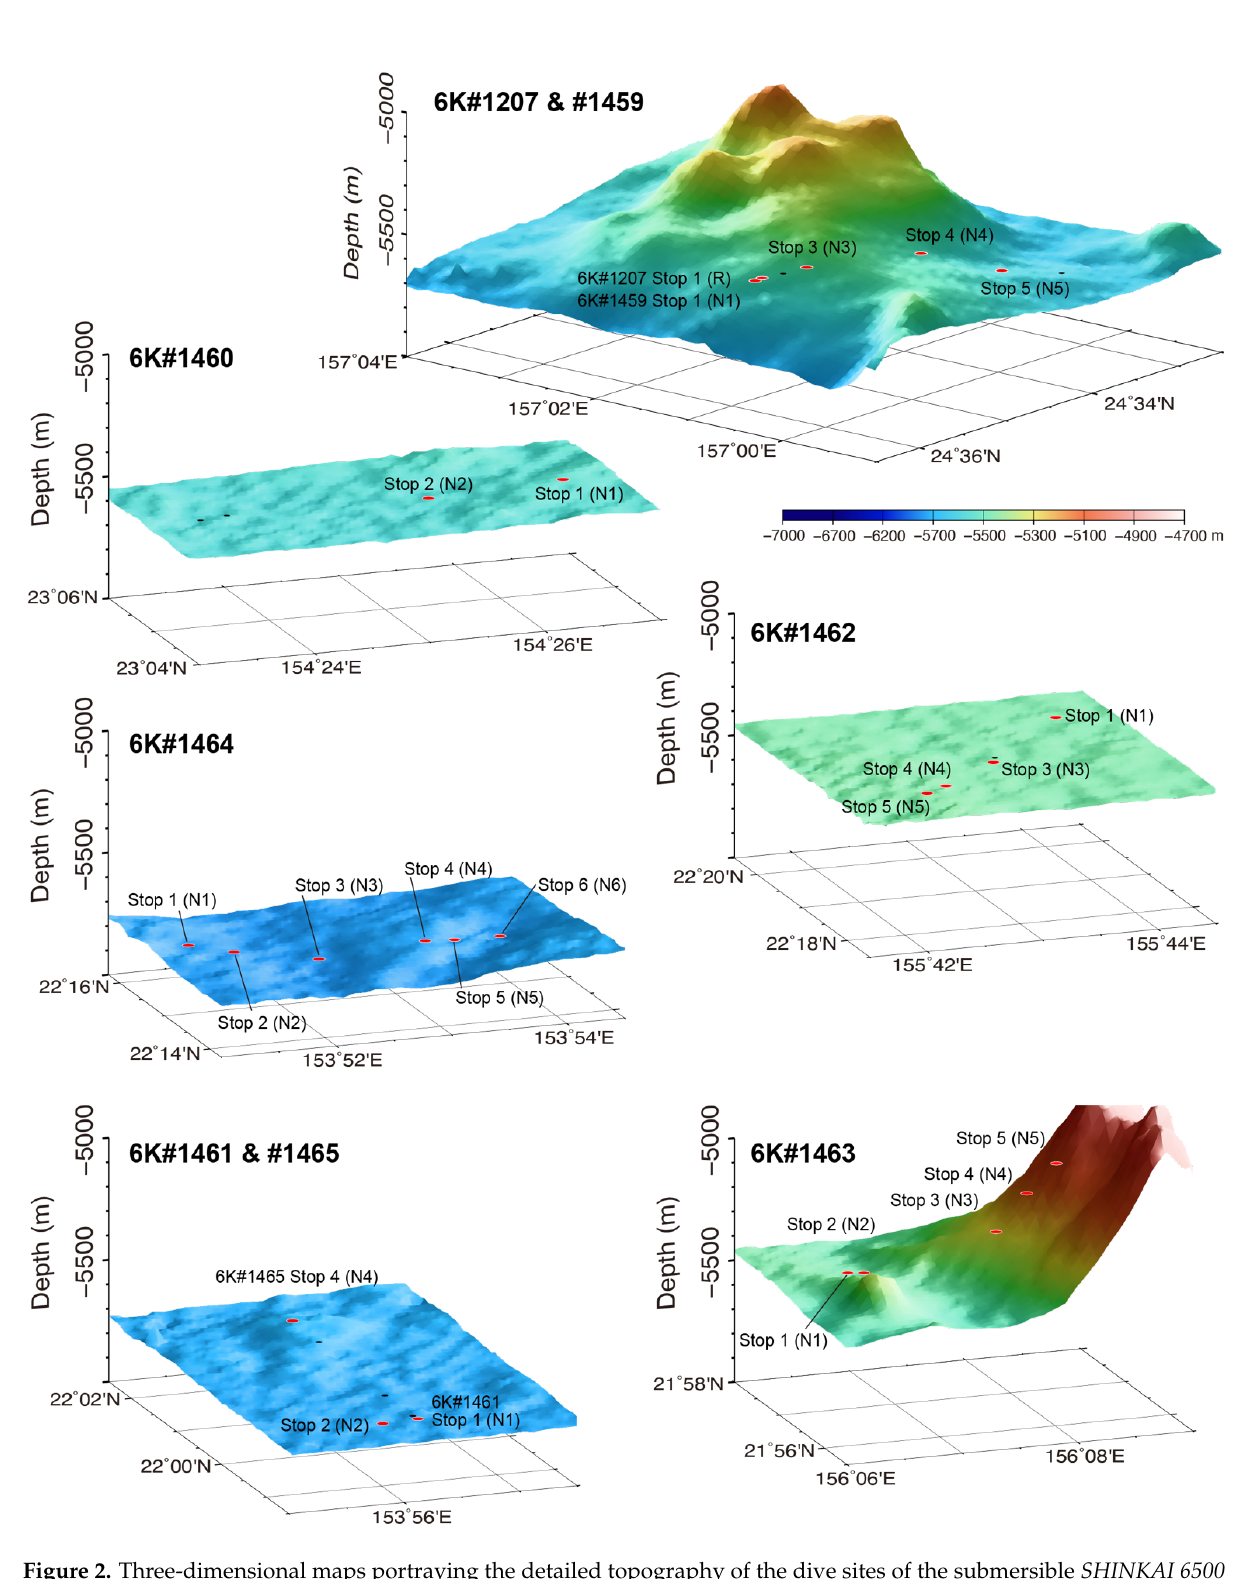
Figure 2. Three-dimensional maps portraying the detailed topography of the dive sites of the submersible SHINKAI 6500 during cruise YK16-01 of R/V Yokosuka . Map of the sites 6K#1207 and #1459 is viewed from N40°W. The other maps are viewed from S40°W. The topographic data of a vessel equipped with MBES were compiled with the published datasets by [13]. Red circles with alphanumeric annotation indicate the stop points for detailed observation and sampling of nodules investigated in this study. The stop numbers correspond to the sample name shown in parentheses. The black dots indicate the other stop points during the same dive.